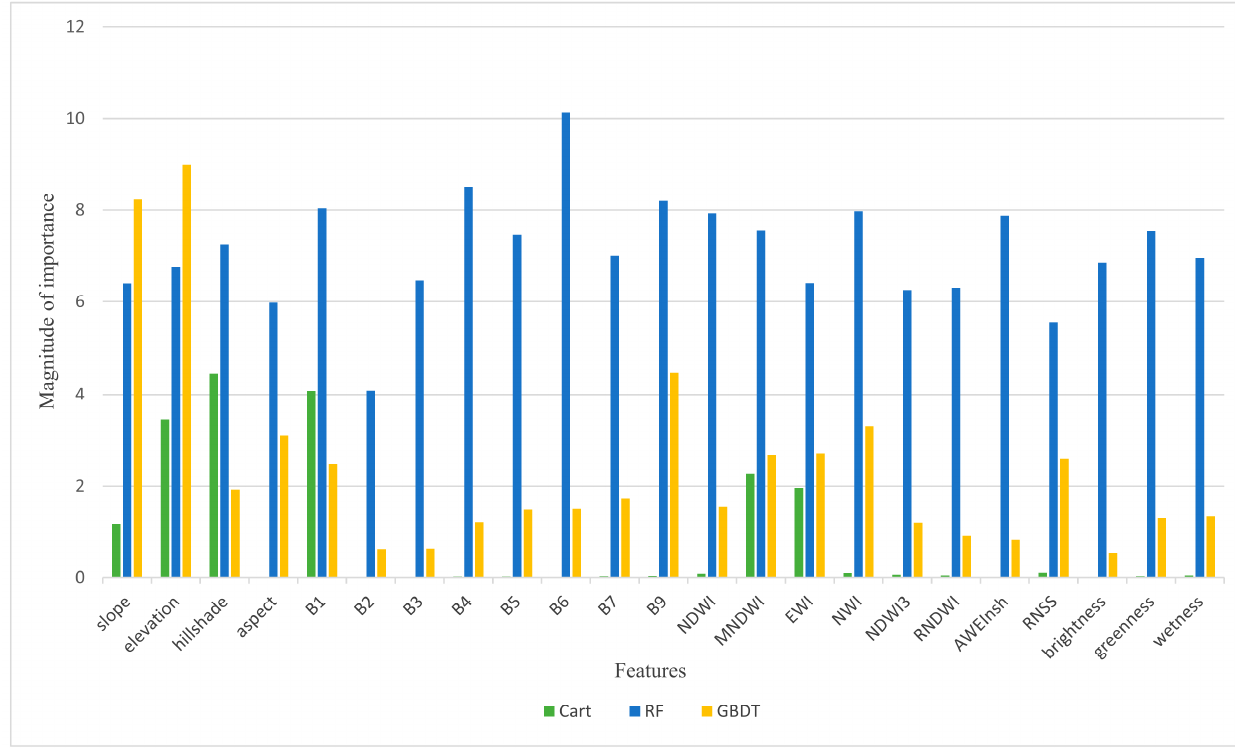
Figure 5. The importance of extracting features of lakes on the Tibetan Plateau in 2016.